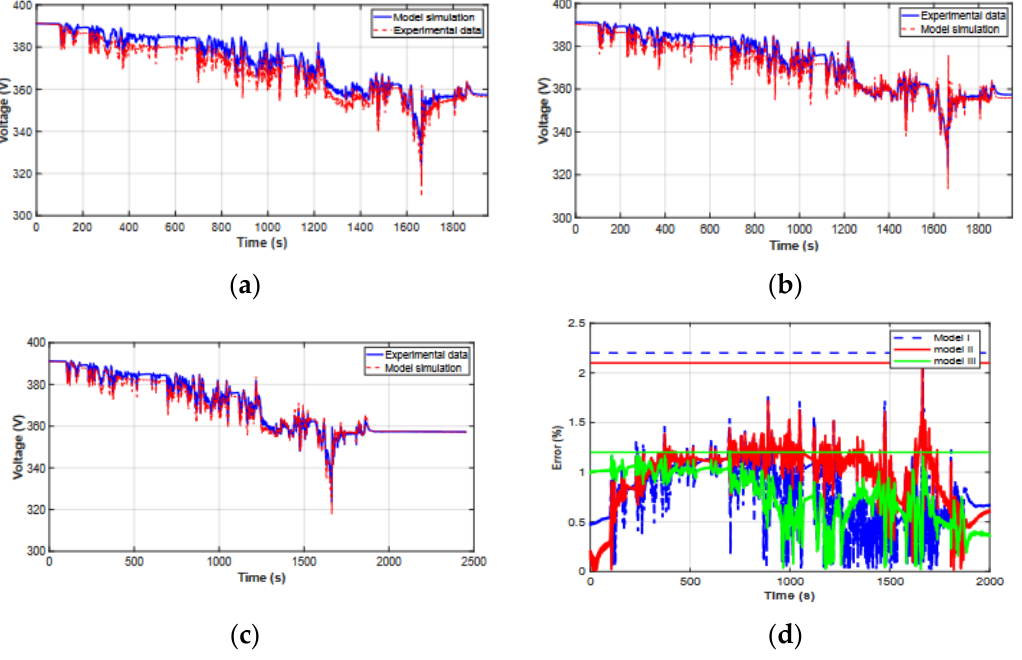
Figure 12. Model validation using WLTC data. Comparison of simulated battery behavior with experimental data over the WLTC using the parameter identification set obtained from the NEDC: ( a ) experimental and simulated voltage during WLTC validation, Model I; ( b ) experimental and simu- lated voltage during WLTC validation, Model II; ( c ) experimental and simulated voltage during WLTC validation, Model III; ( d ) Experimental and simulated voltage during WLTC validation, Model IV.